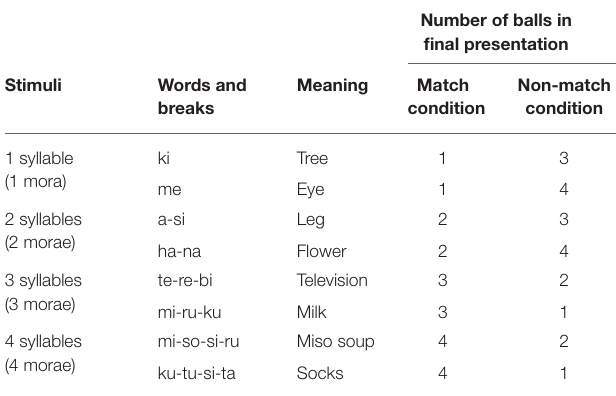
TABLE 4 | Stimuli and ball-presentation conditions in test